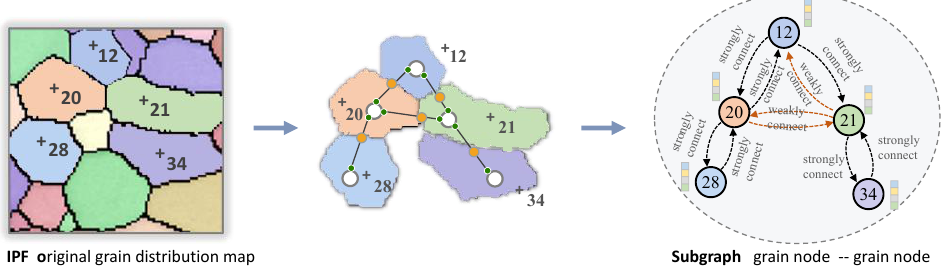
Figure 5. Grain-grain edge construction. According to the connection relationship of the crystal grains (i.e., the grain boundary), the edges between the grain nodes are constructed. Grain-Size Edge Construction. In Section 2.2.1, the size attribute node and the orienta- tion attribute node are constructed. Here, the grain node and the matching attribute node are connected to form a completed grain attribute subgraph. For the size attribute node, we connect it to all matching grain nodes to correlate the size properties of the grains. At the same time, the formed grain size attribute subgraph can reflect the grain size distribution in the microstructure. The specific method is shown in Figure 6, for grains {12, 20, 28, 21, 34}. First, their size levels (categories) {5, 2, 2, 2, 2} are calculated according to Equation (1). Attribute discretization Then, the corresponding size attribute nodes are connected to the grain nodes. “size is” Divide grains into interval (ori category) according to orientation and “size of” are the two relationships between the grain node and the size attribute node.